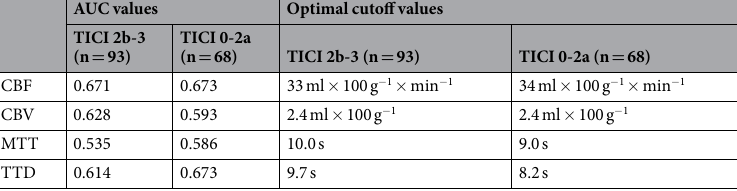
differed between patients with successful recanalization and patients with persistent occlusion. In both patient groups coefficients were consistently positive for TTD and MTT (the higher the perfusion value, the higher the probability of infarction) and negative for CBV and CBF (the lower the perfusion value, the higher the probability of infarction) (Table 3). The real infarct volume was determined for each patient based on the manual segmentations of infarct lesions in follow-up CT datasets. Figure 2 shows the real and predicted infarct